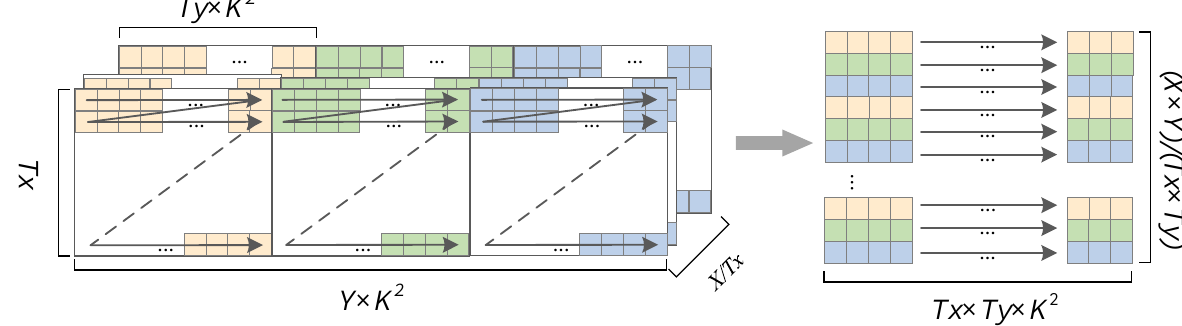
Figure 7. Parameter